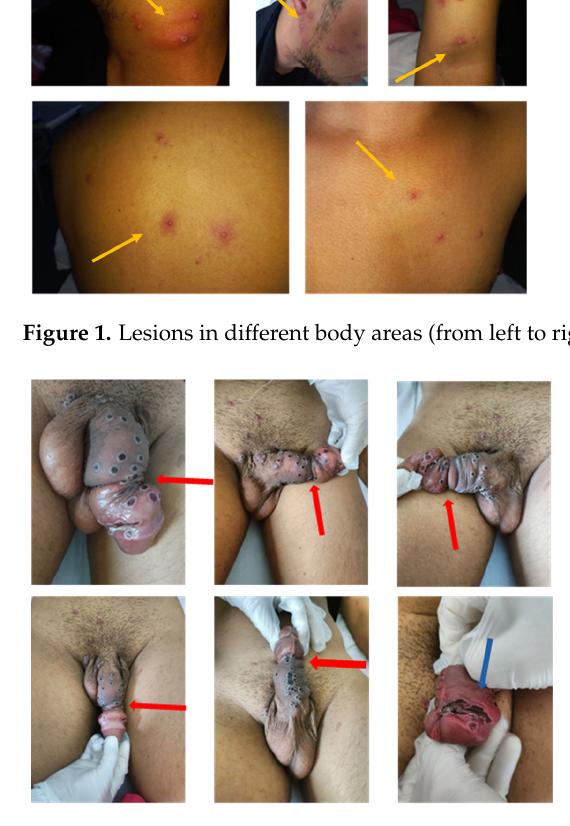
Figure 2. The red arrows indicate, from different perspectives, the penile lesions determining paraphimosis. Blue arrow points to the extensive necrotic area below the coronal sulcus. The patient did not refer to previous paraphimosis.